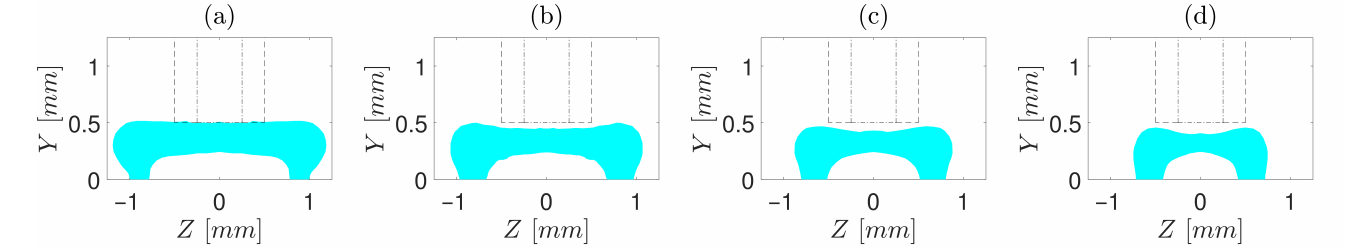
Figure 4. Cross-sections of the core–shell strand for t / D = 0.5, d / D = 0.5 and different V / U of ( a ) 0.5, ( b ) 0.75, ( c ) 1, and ( d ) 1.25. Core diameter and orifice are marked by “- -” and “-·”, respectively.